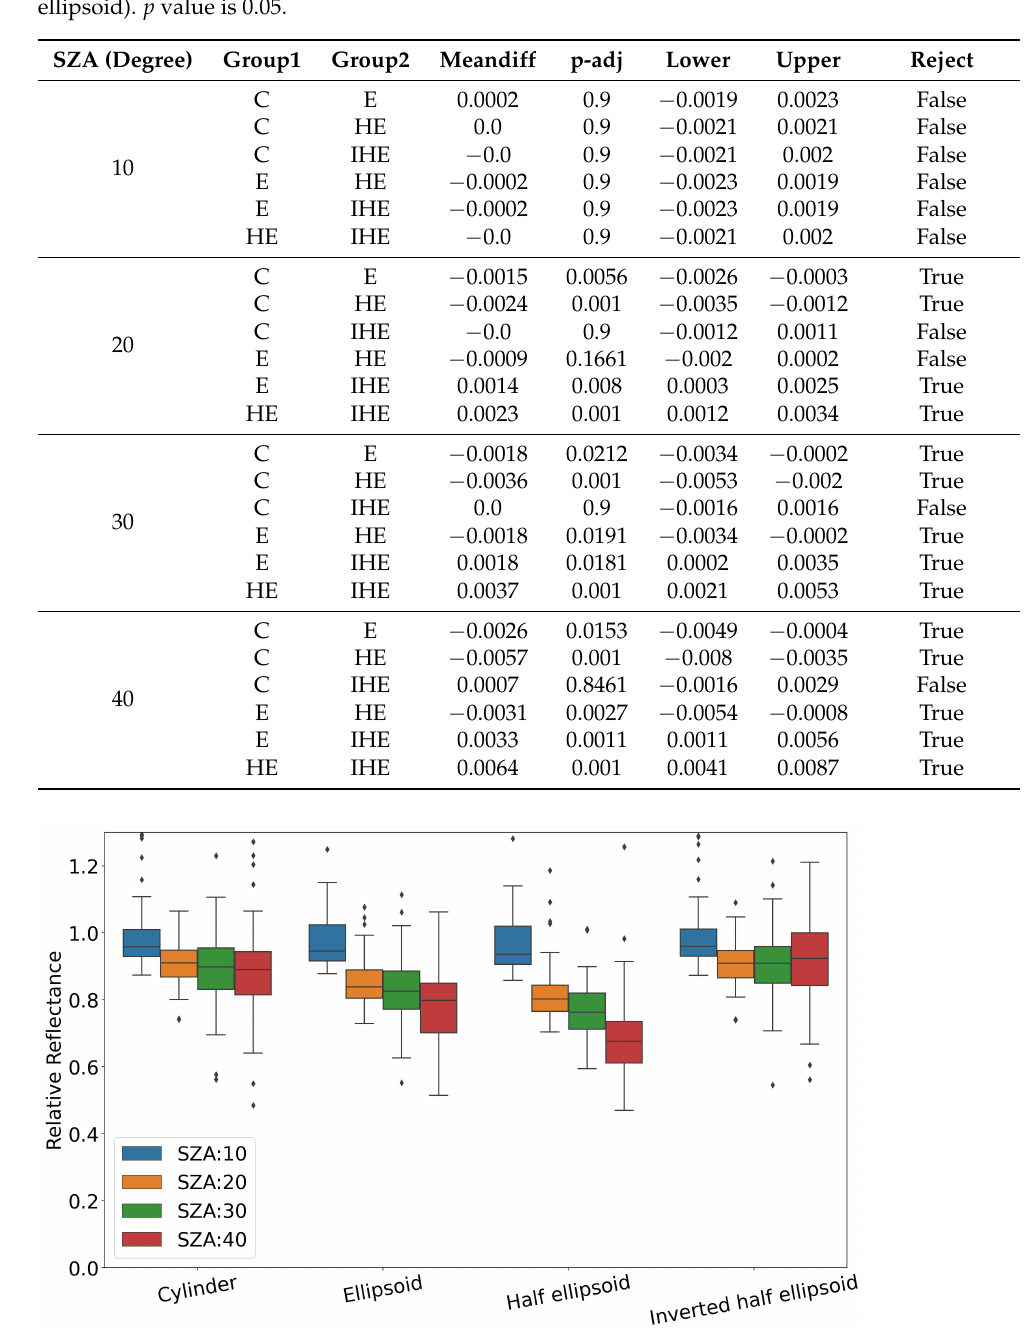
Figure 6. Relative reflectance simulated at SZA from 10 ◦ to 40 ◦ for each tree canopy shape. Base reflectance is mean reflectance at SZA 10 ◦ for each canopy